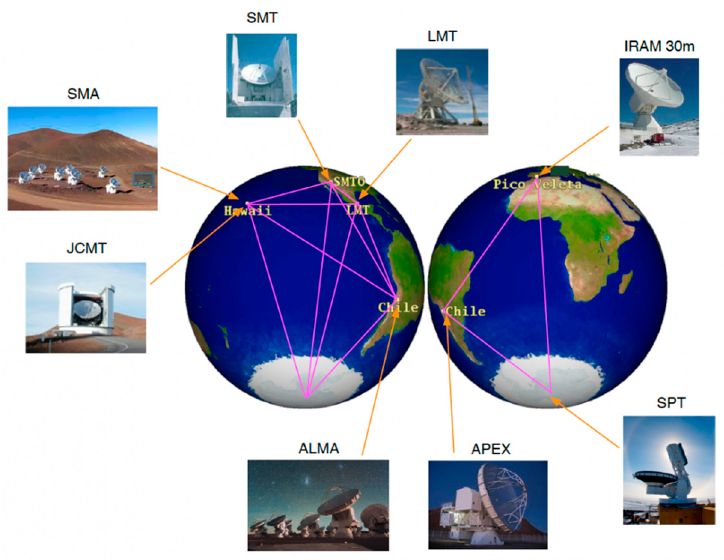
Figure 7. The very large base interferometry (VLBI) network of the Event Horizon Telescope. Courtesy EHT team.